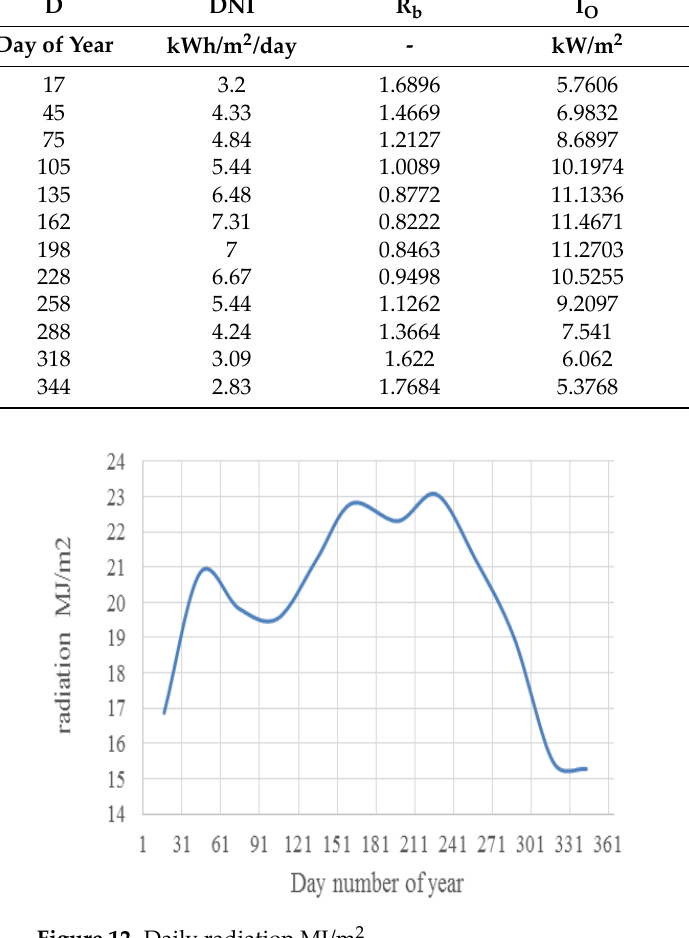
Figure 12. Daily radiation MJ/m 2 .